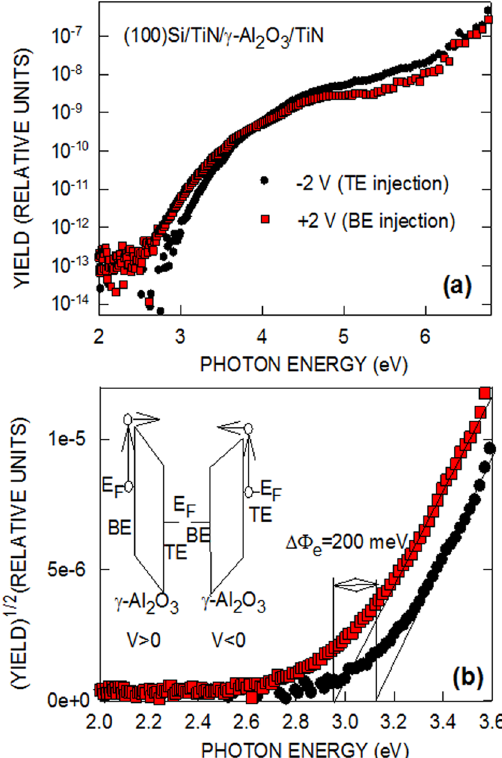
Figure 9. Semi-logarithmic (top) and Fowler (bottom) plots as measured on the TiN/ γ -Al 2 O 3 /TiN sample under the indicated bias voltage applied to the top TiN electrode. The observed signal corresponds to electron IPE from the bottom electrode (BE) and top electrode (TE), respectively, as illustrated in the inset in bottom